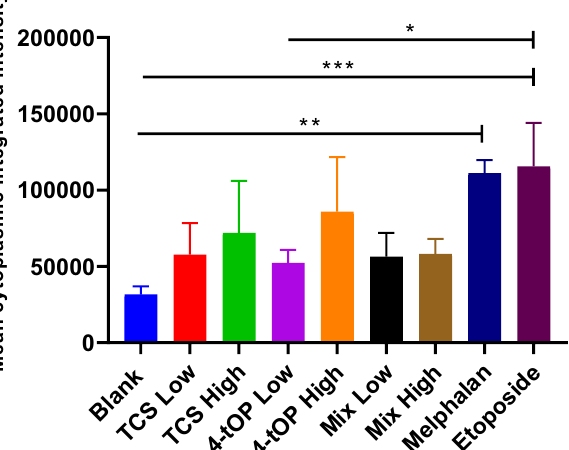
Figure 4. Estimates of the activity of the reactive oxygen species. p values * = 0.04, ** = 0.0064, *** = 0.0038, n = 3.